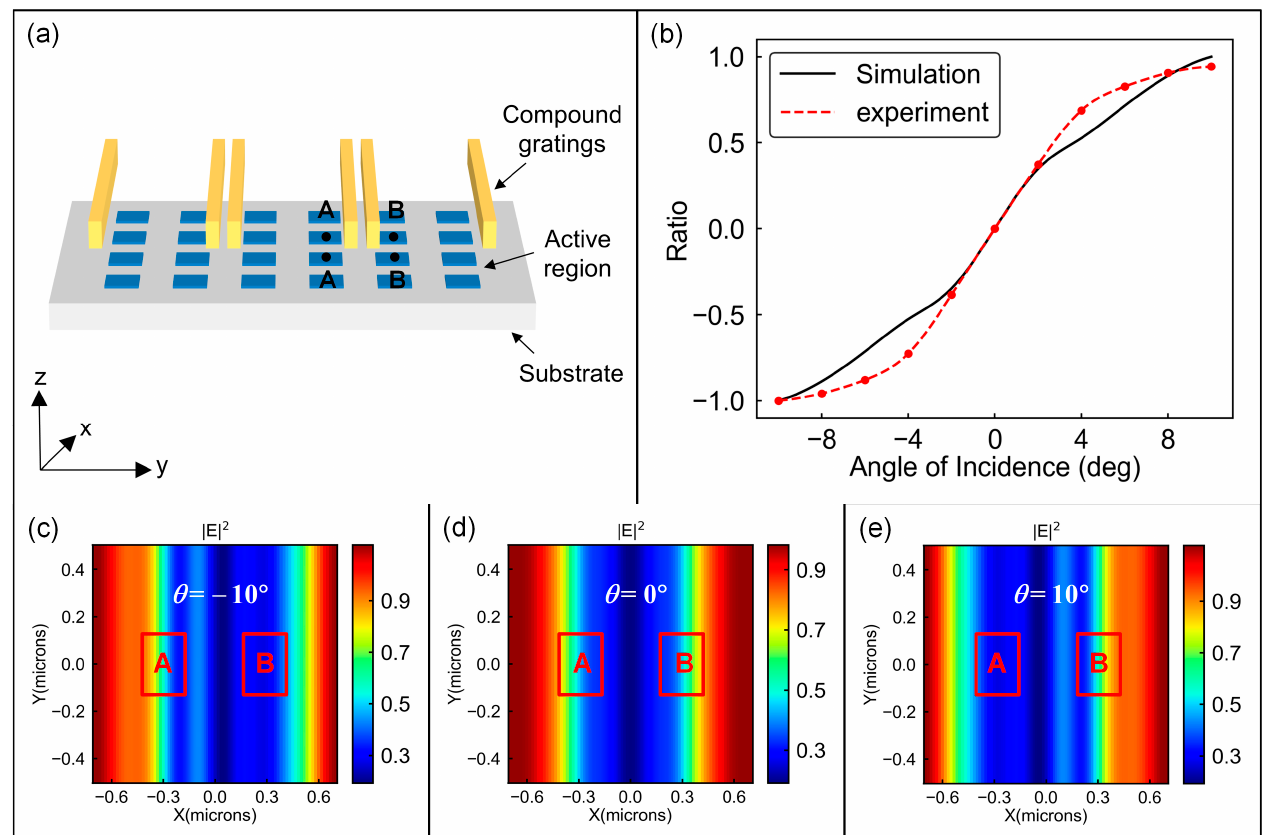
Figure 1. Performance of the proposed angle-sensitive pixels (ASPs). ( a ) Schematic diagram of the ASPs. Yellow lines represent the subwavelength compound gratings and blue squares represent the active regions of the pixels. ( b ) Angle dependence of the energy ratio between two adjacent pixels, measured at a wavelength of 532 nm. The energy ratio is a function of the incidence angle of light. ( c – e ) Light intensity distribution on two adjacent pixels for different incidence angles, where the red rectangles represent the active regions of the pixels.